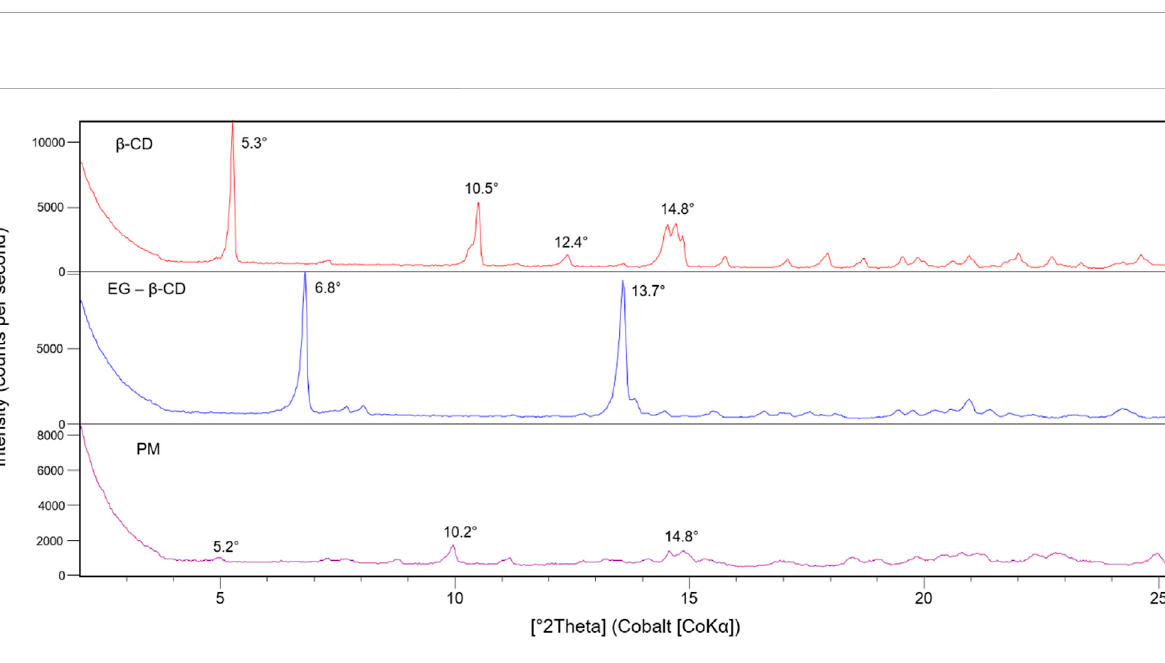
FIGURE 2 Diffraction patternsoffree β -cyclodextrin( β -CD), eugenol – β -cyclodextrin(EG- β -CD)complex,andphysicalmixture(PM)wereanalyzedusing the